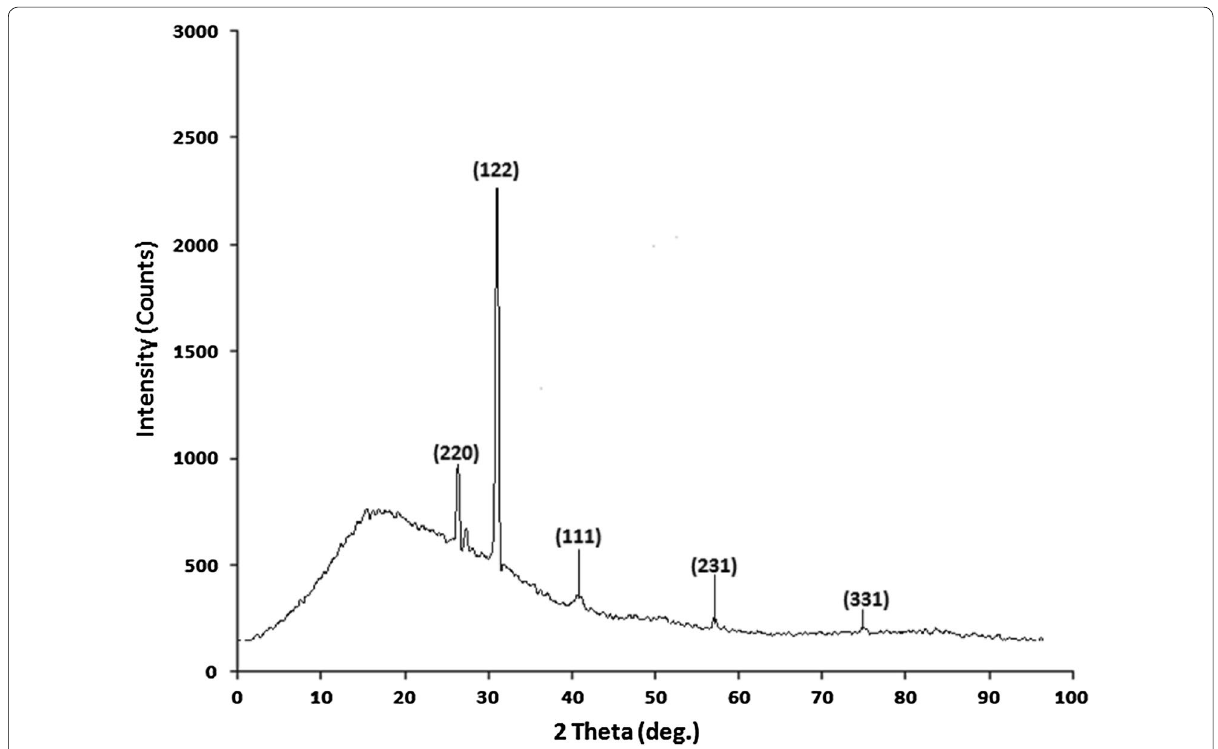
Fig. 6 XRD pattern of the synthesized silver nanoparticles from A. calcarata